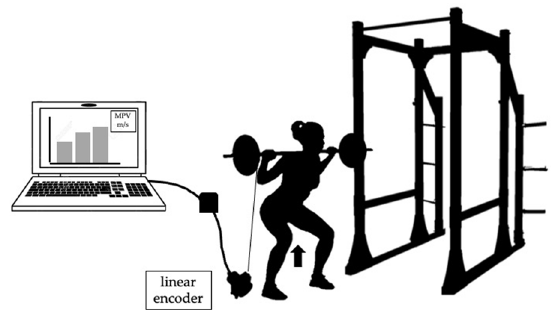
Figure 3. Squat test.